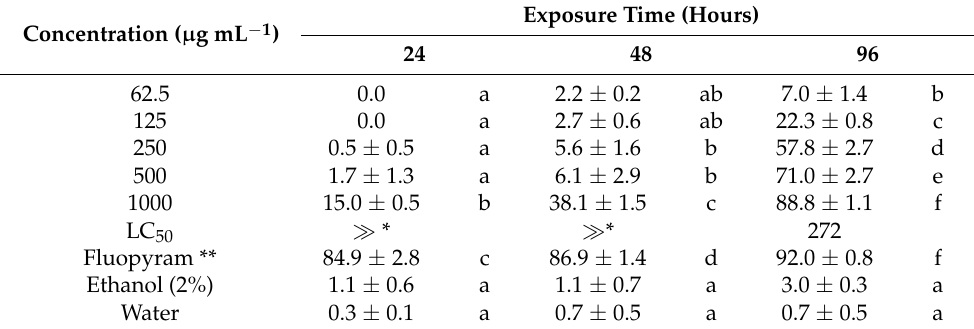
Table 3. Percentage mortality (mean ± SE) of infective juveniles of Meloidogyne incognita after a 24-, 48-, or 96-h exposure to 62.5–1000 µ g mL − 1 concentrations of the tannin extract from Hedysarum coronarium biomass. Exposure Time (Hours) Concentration ( µ g mL − 1 ) 24